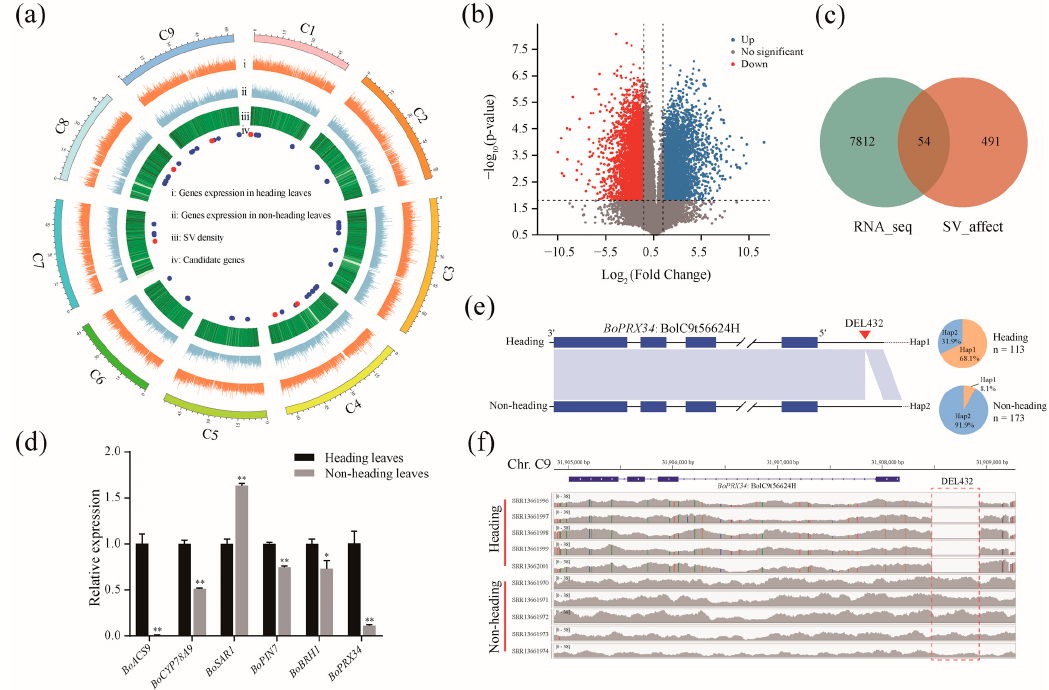
Figure 5. SVs in genes involved in heading leaf trait of cabbage. ( a ) Circular diagrams of gene expression and genomic variation between heading and non-heading accessions. The outermost layer illustrates the distribution of the nine chromosomes of B. oleracea HDEM in megabases (Mb). Tracks of (i) and (ii) show the distribution of expression of genes from heading and non-heading leaves with three biological replicates, respectively. Gene expression was calculated as the fragments per kilobase of transcript per million mapped reads (FPKM) and normalized by log 10 (FPKM + 1). (iii) The density of SVs in 200 kb bins. (iv) Location of candidate genes, including six identified genes highlighted by the red solid circle for heading trait. ( b ) Volcano plot showing the fold change (x-axis) and significance level of the differential expression (y-axis) between heading leaves and non-heading leaves of cabbage, based on normalized RNA-seq read counts. The gray dashed lines represent